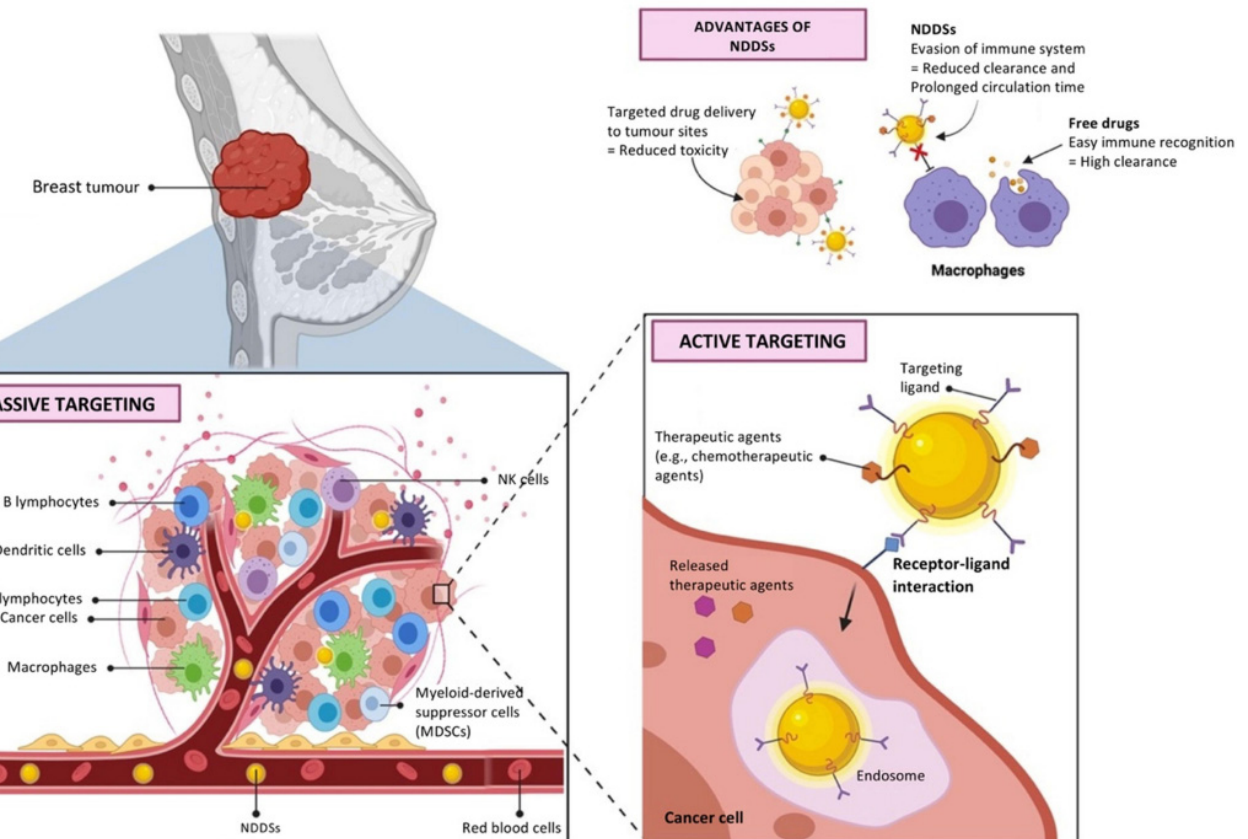
Figure 5. Schematic design for targeted drug delivery system procedure based on AuNPs. Reproduced with permission from [93], Dove Press, 2021.